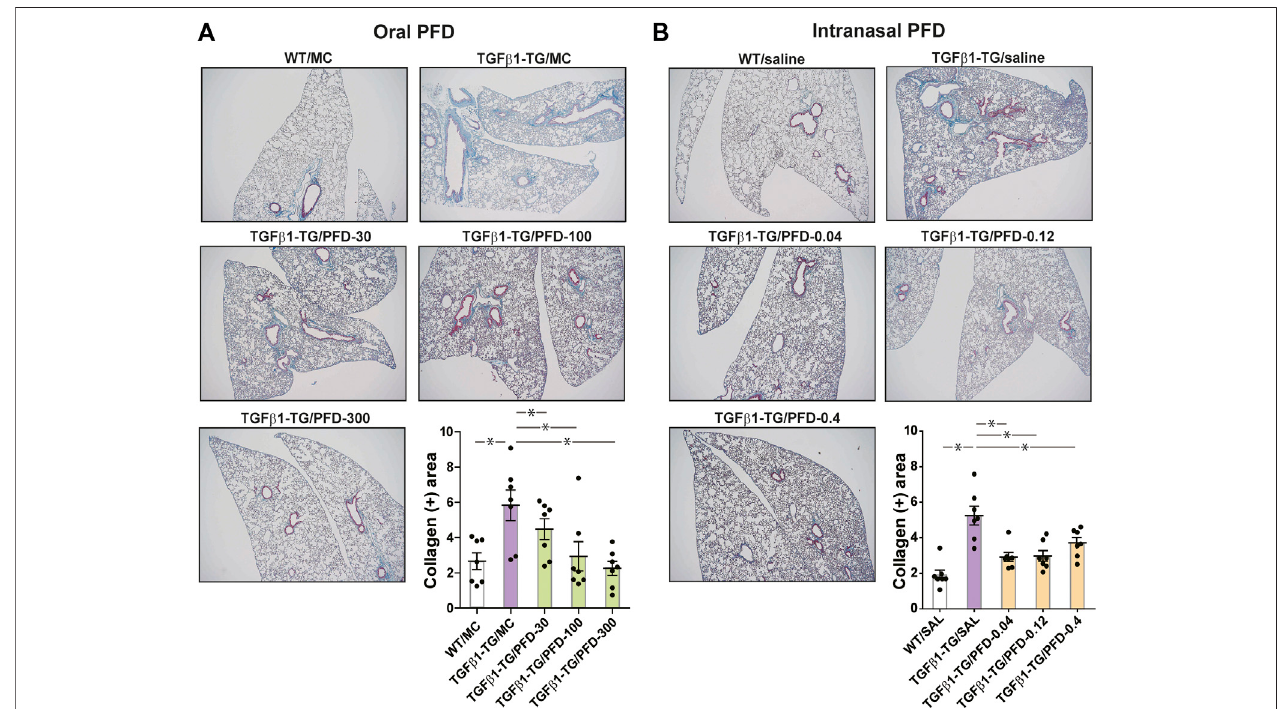
FIGURE4| Signi fi cantreductioninthelung fi broticareaaftertreatmentwithoralorintranasalpirfenidone(PFD)compared tocontrols.Humantransforminggrowth factor (TGF) β 1 transgenic (TG) mice were allocated in groups treated with PFD by oral ( A ; n (cid:2) 7) or intranasal ( B ; n (cid:2) 7) administration and in groups treated with the vehicle saline (SAL; n (cid:2) 7) or with the vehiclemethylcellulose (MC; n (cid:2) 7) twice a day for 21 days and once a day on day 22 before euthanasia. Wild type (WT; n (cid:2) 7) mice treated with saline or MC were used as negative controls. Lung tissue was stained with Masson ’ s trichrome, and the fi brotic stained area was calculated using the WINDROOF image software as described under materials and methods. Scale bars indicate 500 µm. Data are expressed as the mean ± S.E.M. Statistical analysis by Student ’ s t -test and ANOVA with Dunnett ’ s post hoc test. * p < 0.05.